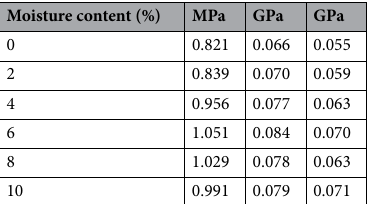
Moisture content